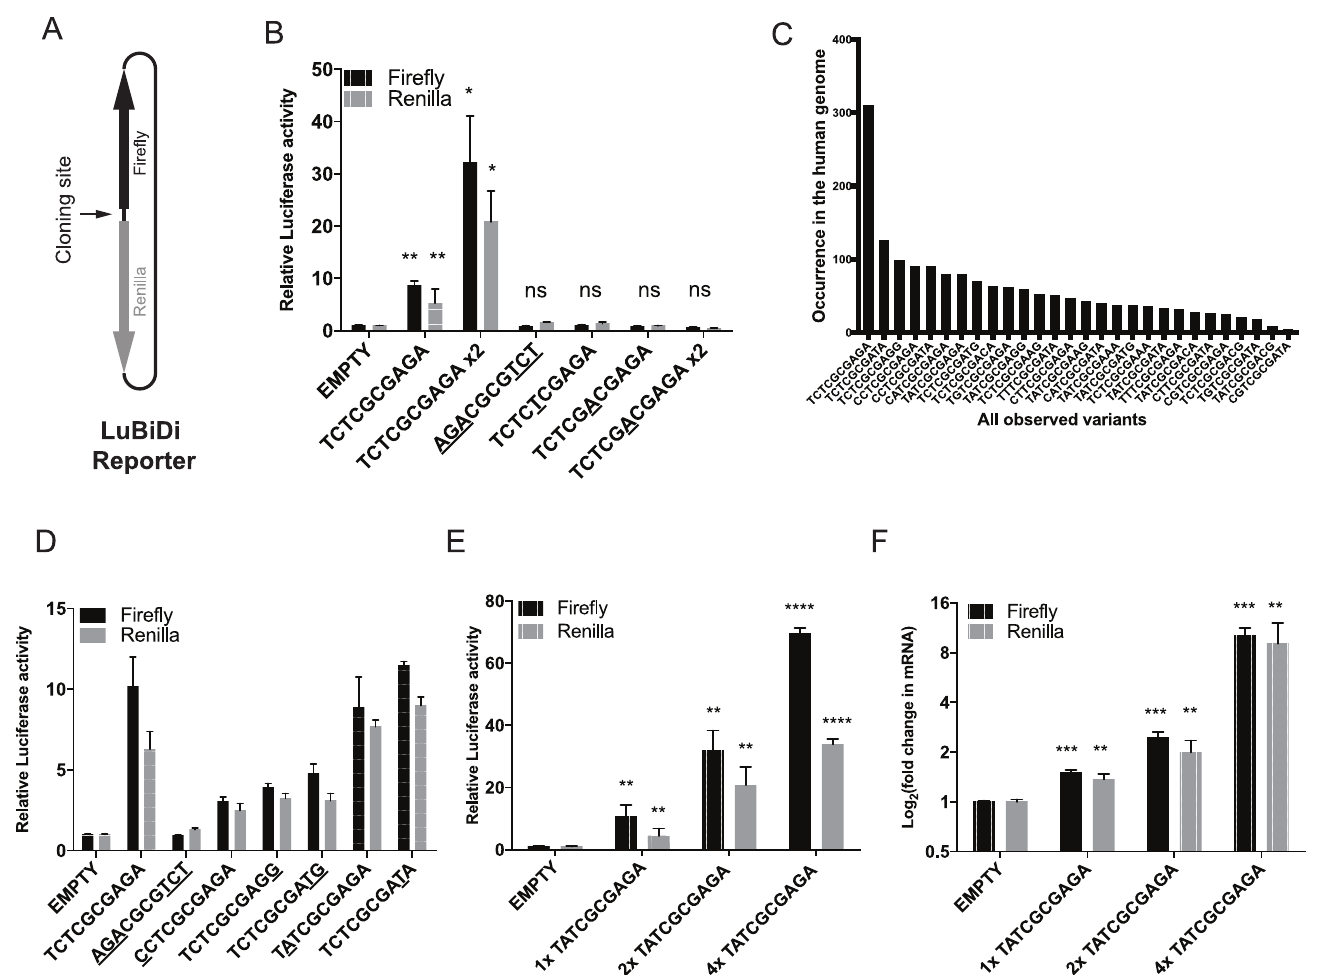
Fig 3. CGCG elements promote bidirectional gene expression in the LuBiDi reporter system. A) The structure of the LuBiDi reporter construct. B) One copy of the TCTCGCGAGA motif inserted in the LuBiDi construct was sufficient to activate the expression of both firefly and Renilla reporters. Flank-exchanged (AGACGCGTCT), G ! T transversion mutation (TCTCTCGAGA), or an insertion mutation in the middle of CGCG (TCTCGACGAGA) abolished the dual activation. C) The frequency of common CGCG element sequence variants in the human genome. D) The bidirectional promoter activity of selected naturally- occurring CGCG element variants. E) The effect of CGCG element copy number (TATCGCGAGA motif) in LuBiDi on reporter activity. F) Corresponding transcript levels from reporters in panel